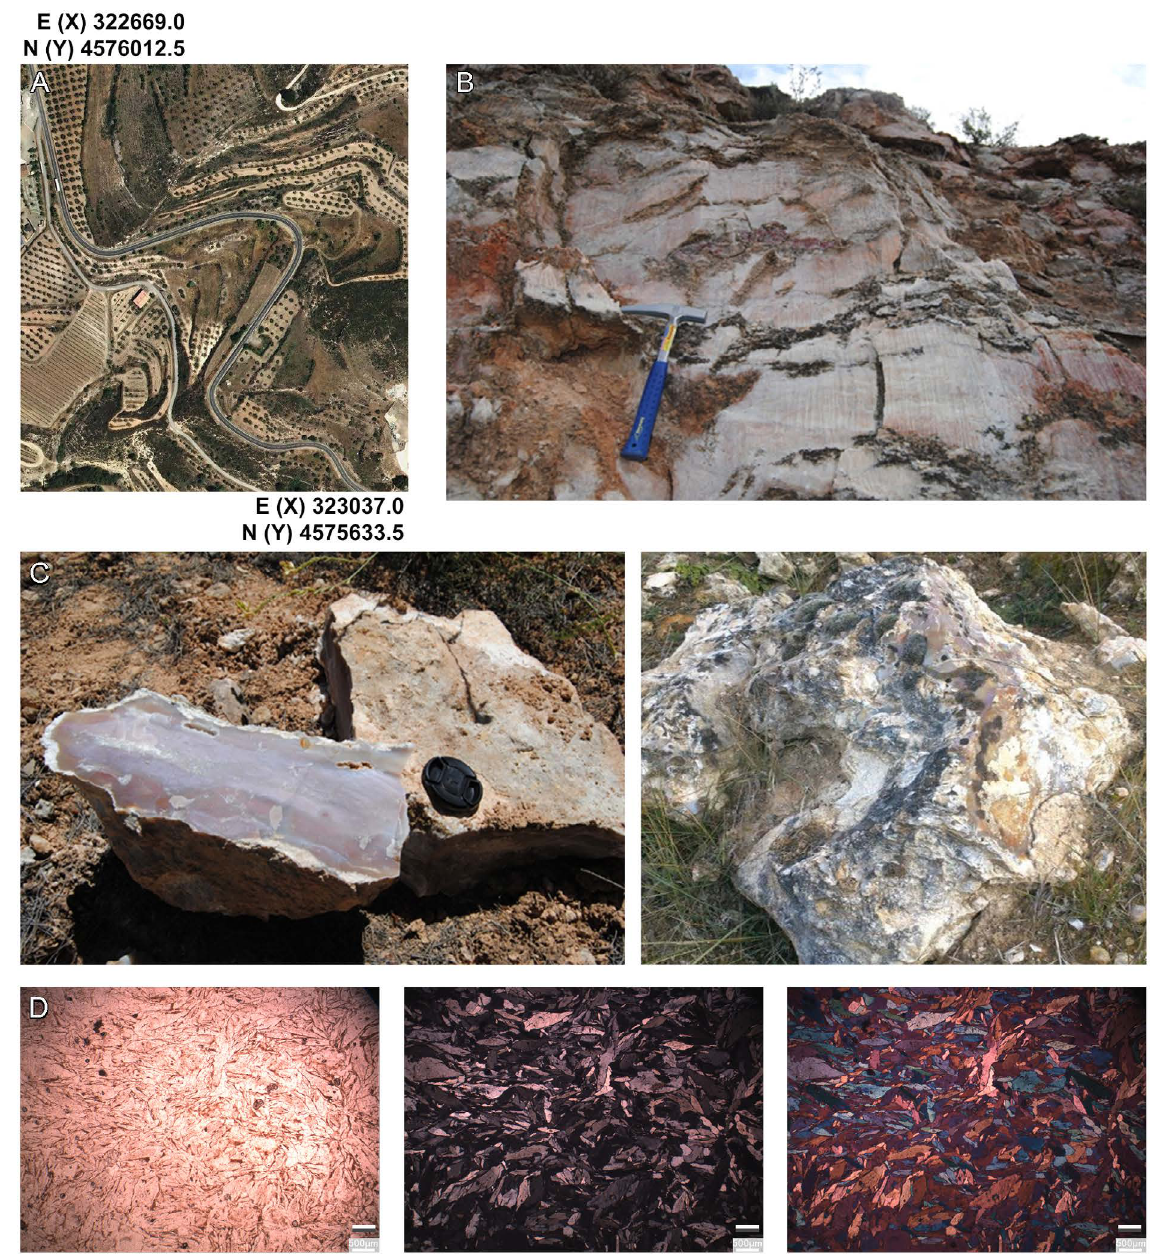
Figure 6. A) Area of the second stop of the Silica Road Trip (UTM 31N-ETRS89). B-C) Outcrop section and details of the Ulldemolins chert nodules. D) Thin sections images from an Ulldemolins chert showing their high content of gypsum crystals (Soto